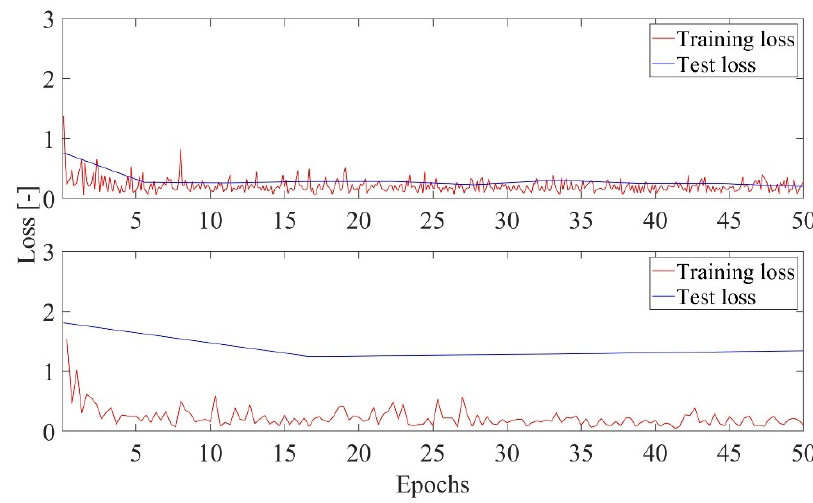
Figure 4. Training loss and test loss in normal (top) and undersampling (bottom).